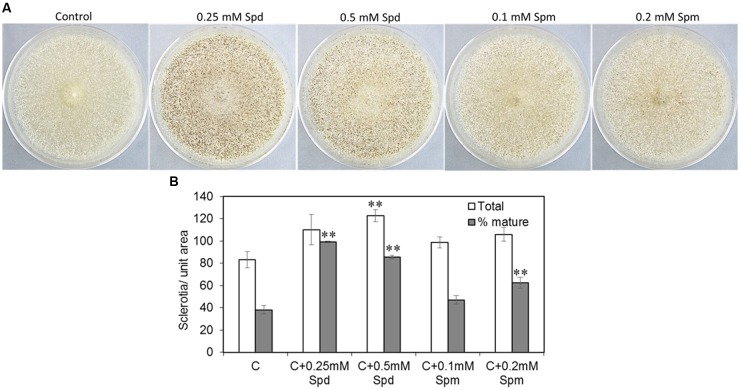
Spermidine affects sclerotial formation. (A) Sclerotial morphology of A. flavus AF70 wild type (WT) strain grown on solid Czapek’s (CZ) medium supplemented with different concentrations of Spd and Spm along with control (no PAs); and (B) Mature (melanized) vs. total sclerotia counts for the AF70 strain grown on solid CZ medium supplemented with Spd and Spm along with control (no PAs). The cultures were grown in the dark for 14 days at 30°C. Data are Mean ± SE of four replicates (∗∗P ≤ 0.05 between control and treatment, based on Student’s t-test).